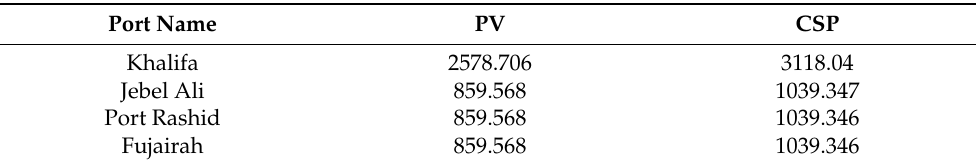
Table 10. Amount of H 2 produced at each port using the proposed shortest electric grid in the sec- ond pathway from PV and CSP in (kg × 10 6 ). Table 9. Amount of H 2 reaching each port using the proposed shortest routes in the first pathway from PV and CSP in (kg × 10 6 ).